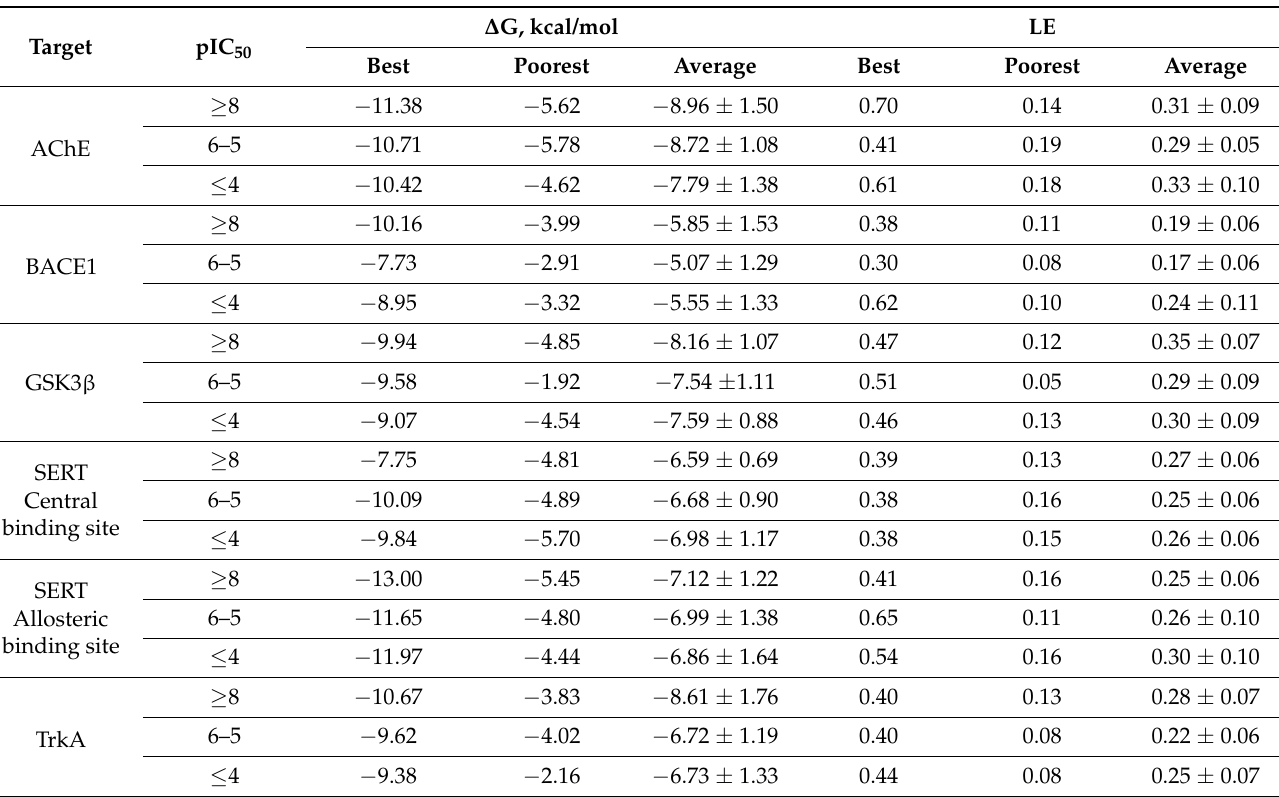
Table 5. The best (lowest binding energy), poorest (highest binding energy) and average values of calculated Glide SP binding energies ( ∆ G, kcal/mol) and ligand efficiencies (LE). The average values of binding energies and LEs are presented as mean ±